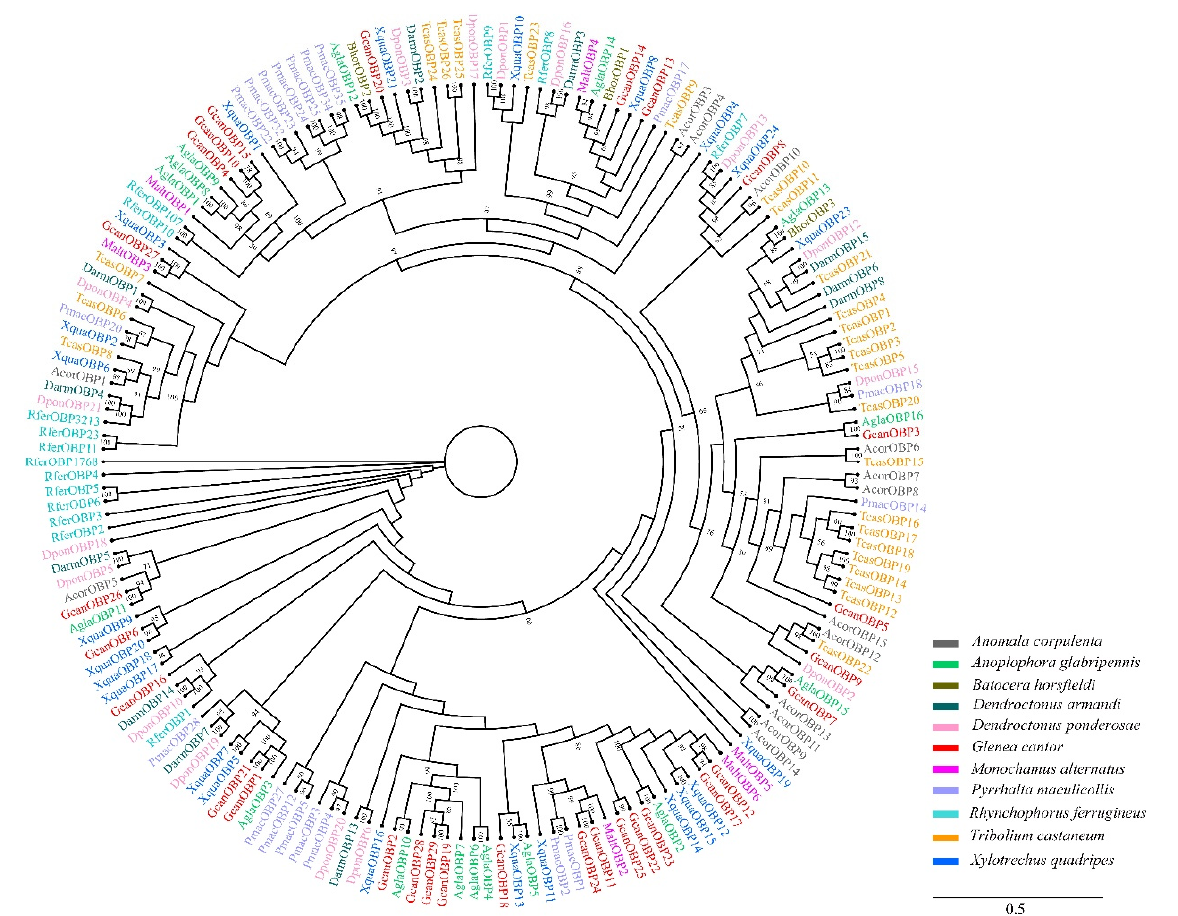
Figure 2. Phylogenetic analysis of insect odorant binding proteins (OBPs). Information of OBPs was listed in Table S3. Anomala corpulenta (Acor), Anoplophora glabripennis (Agla), Batocera horsfieldi (Bhor), Dendroctonus armandi (Darm), Dendroctonus ponderosae (Dpon), Monochamus alternatus (Malt), Pyrrhalta maculicollis (Pmac), Rhynchophorus ferrugineus (Rfer), Tribolium castaneum (Tcas), and Xylotrechus quadripes